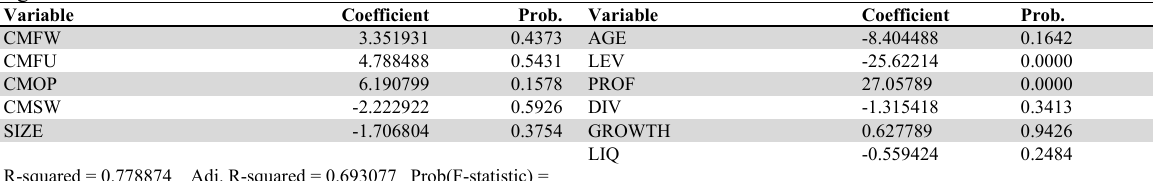
Regression Model 5